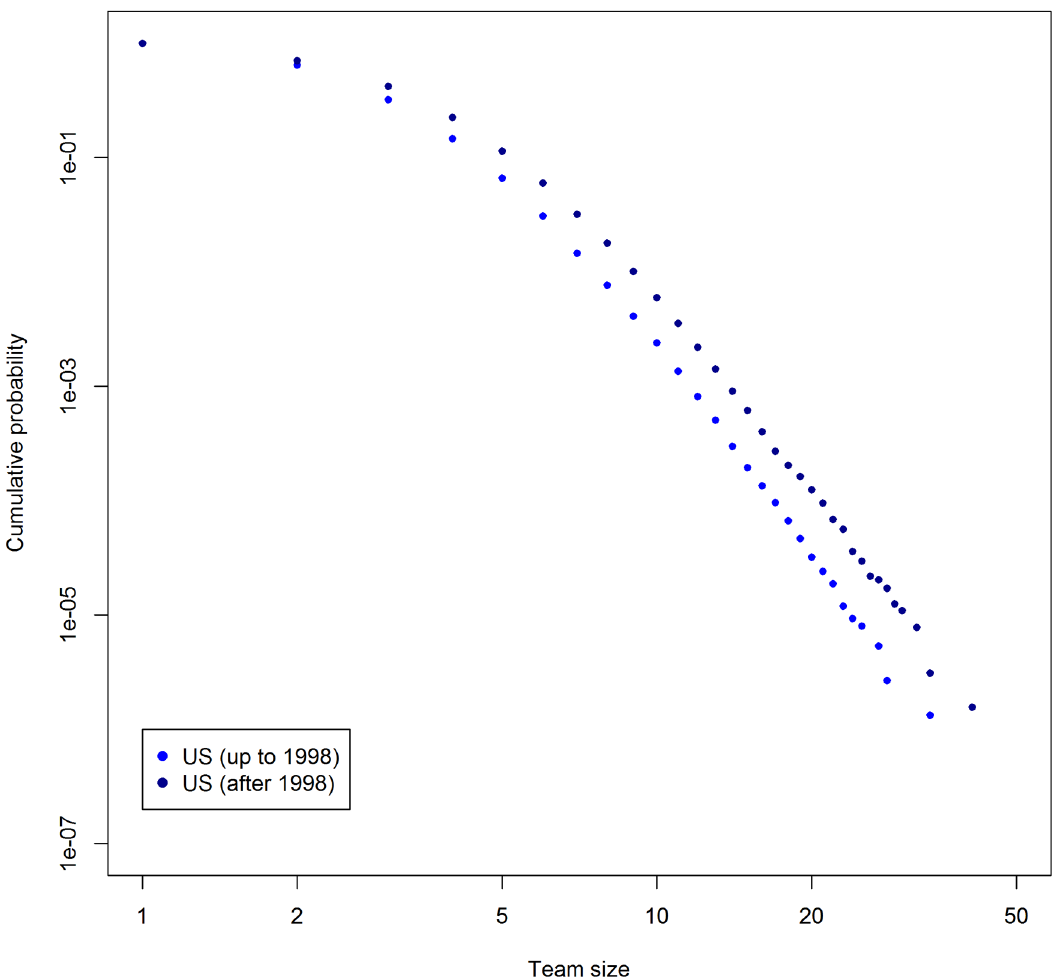
Fig 3. Cumulative probability distribution of team size in the U.S. Horizontal axis shows team size. Vertical axis shows cumulative probability. Data is separated around middle of duration.